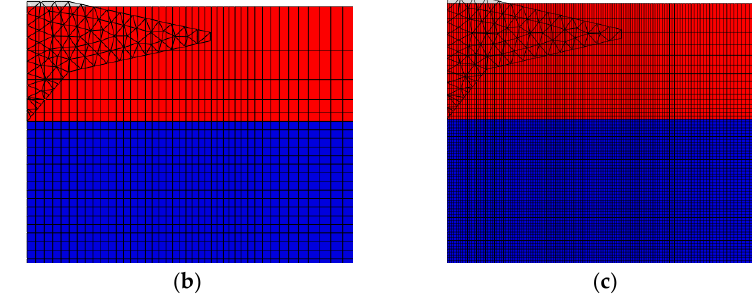
Figure 4. Mesh close to the spudcan with different mesh sizes: ( a ) 0.05 D ; ( b ) 0.02 D ; ( c ) 0.005 D .